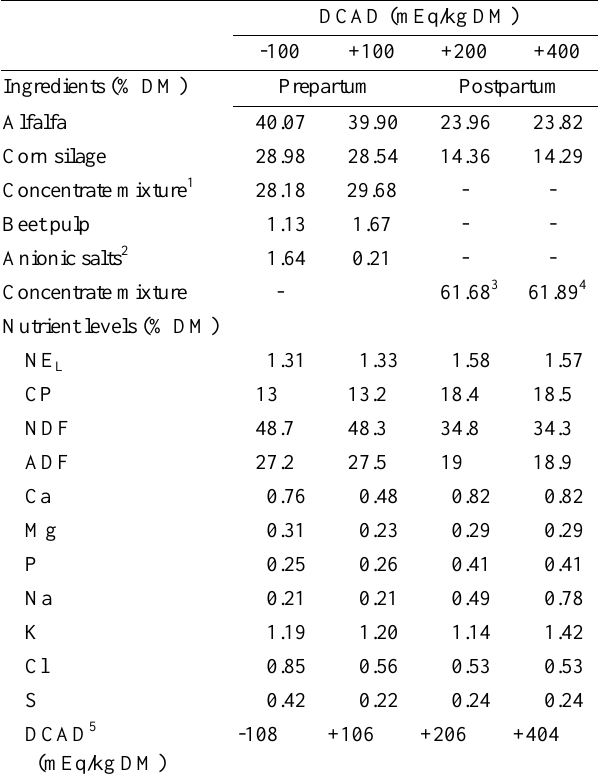
Table 1. Ingredients and chemical composition of diets for dairy cows in pre and post-partum